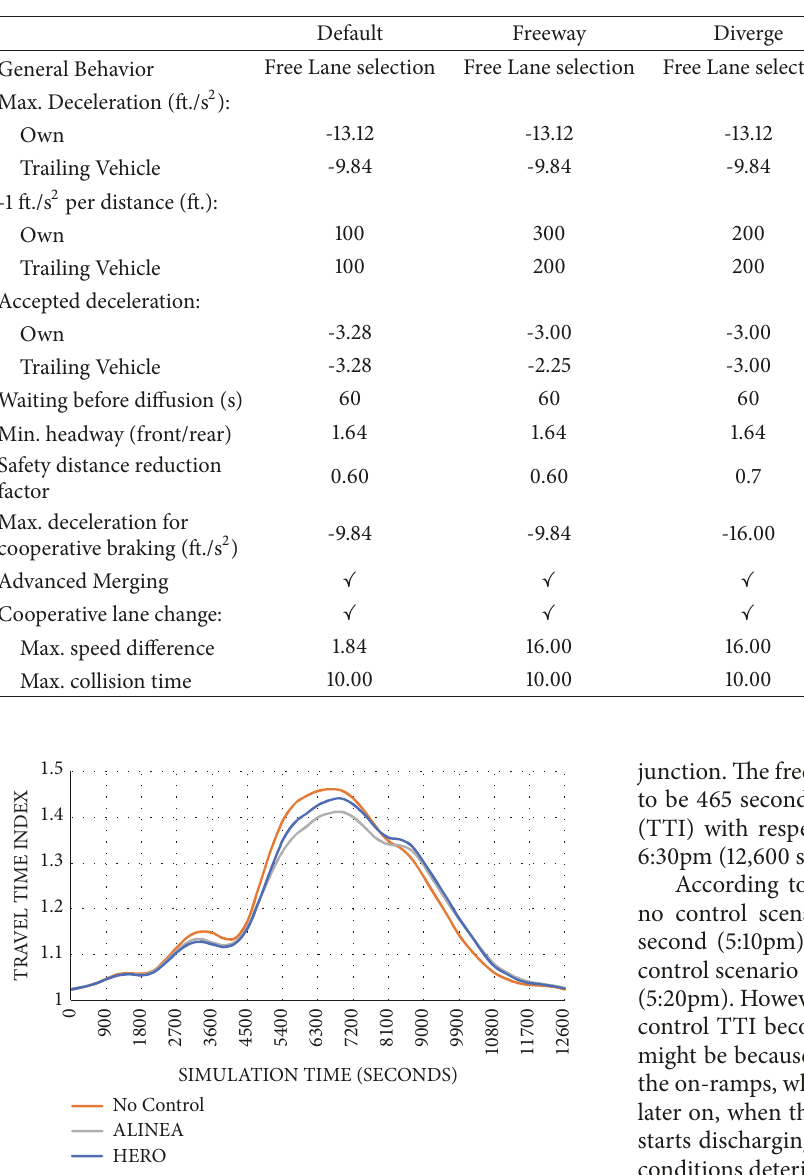
Table 2: Calibrated lane change parameters.